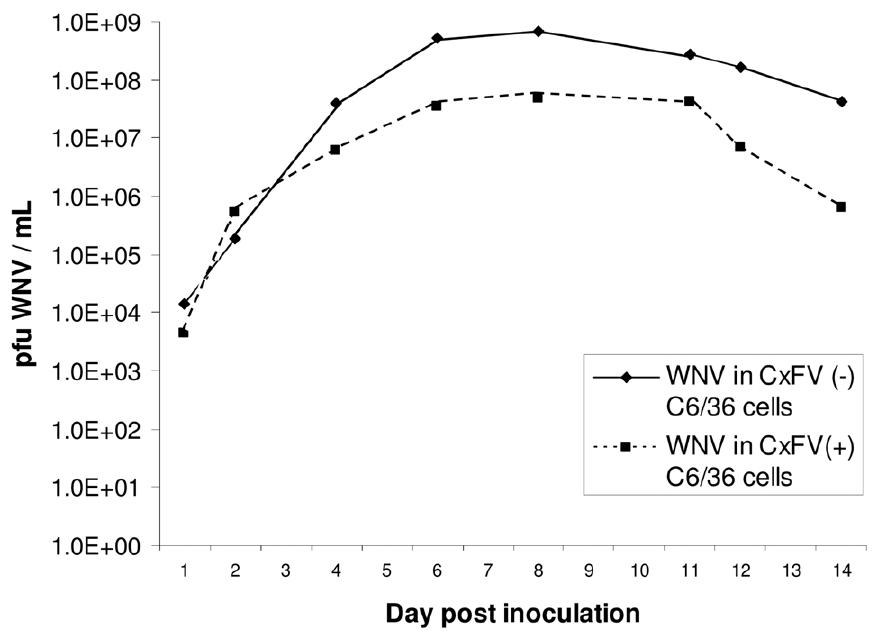
Figure 4. Replication of WNV in CxFV Izabal ( + ) and CxFV Izabal ( 2 ) C6/36 cells. CxFV ( + ) cells were infected two days prior to re-infection with WNV.